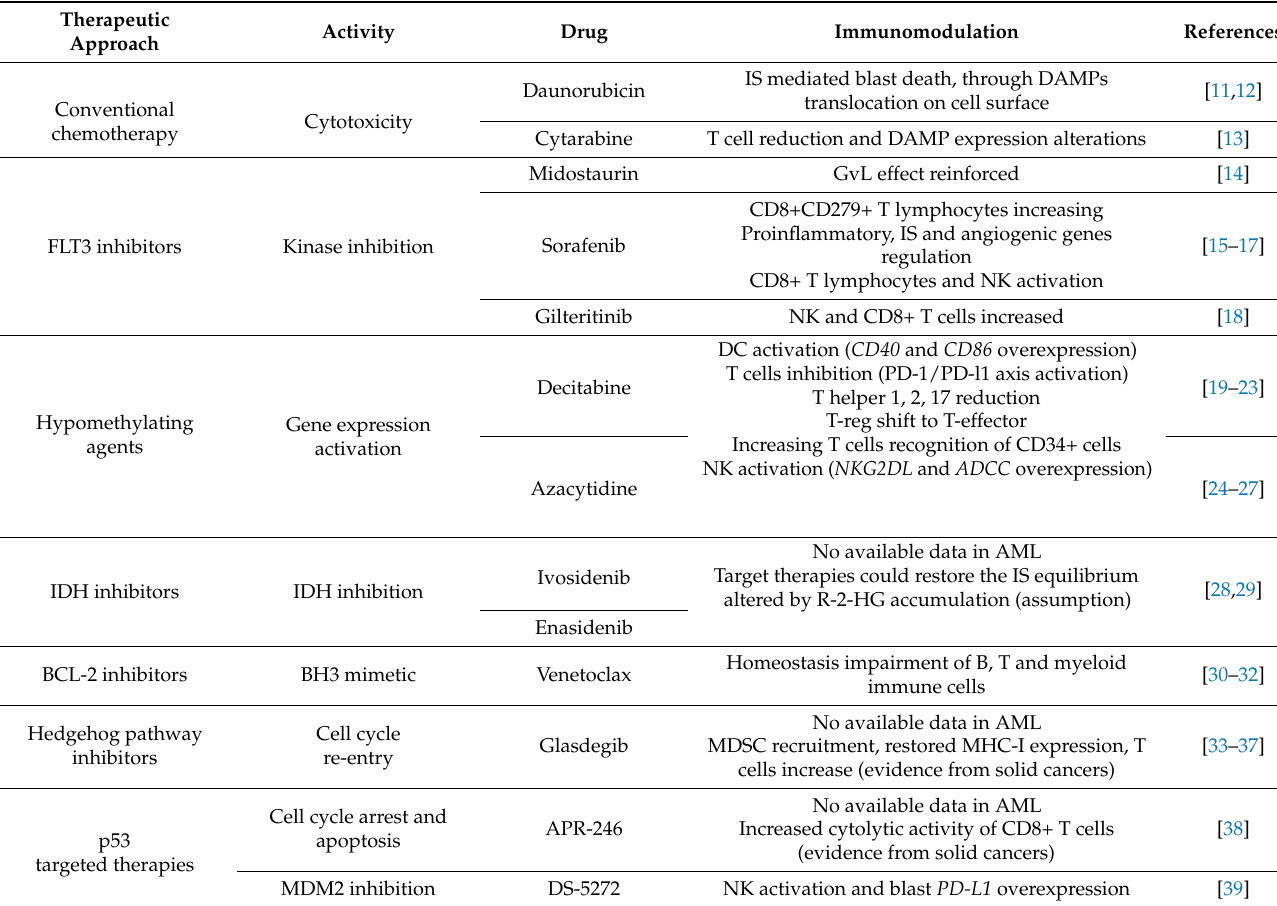
Table 1. Main immunomodulatory effects of the AML therapeutic approaches. The principal effects on the IS of the drugs currently used in AML patient management. For each molecular mechanism, the main literature references are reported. AML: acute myeloid leukemia, IS: immune system, DAMP: damage-associated molecular pattern molecules, GvL: graft versus leukemia, NK: natural killer cell, DC: dendritic cell, T-reg: T-regulatory cells, R-2-HG: R-2-hydroxyglutarate, MDSC: myeloid-derived suppressor cell and MHC-I: major histocompatibility complex class